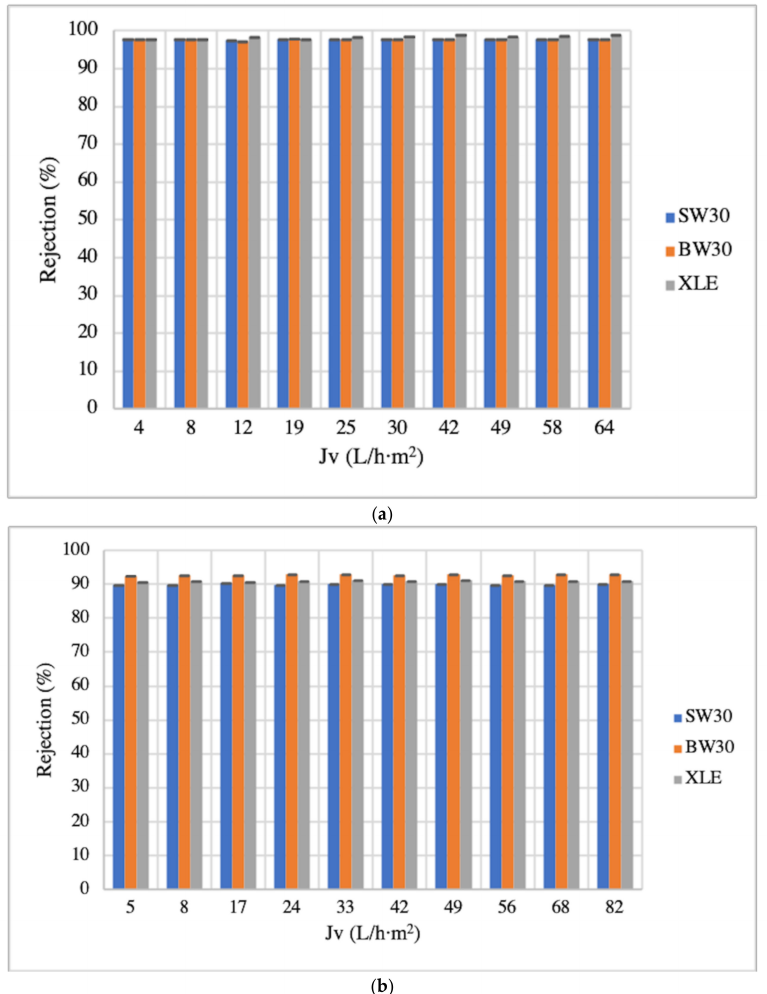
Figure 5. RO rejection evolution with permeate flux of spinach and orange matrices (( a , b ),